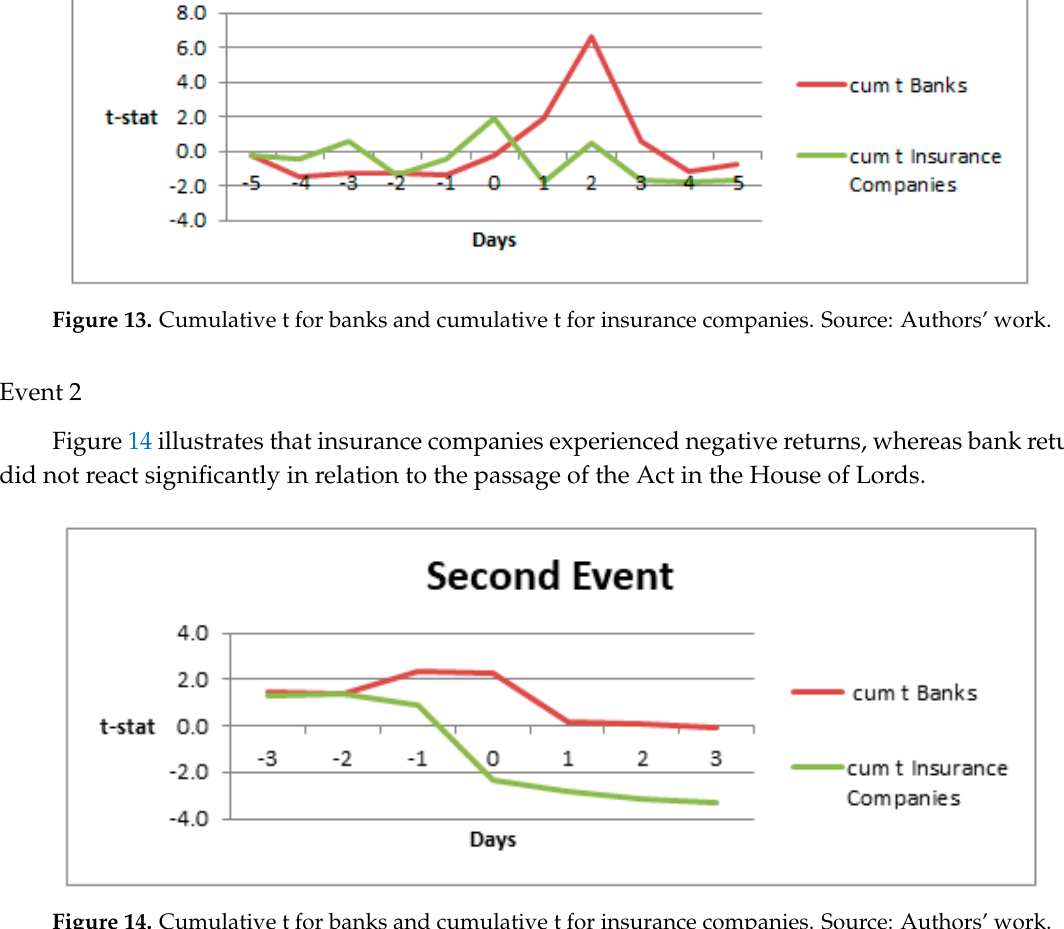
Figure 14. Cumulative t for banks and cumulative t for insurance companies. Source: Authors’ work. Event 3